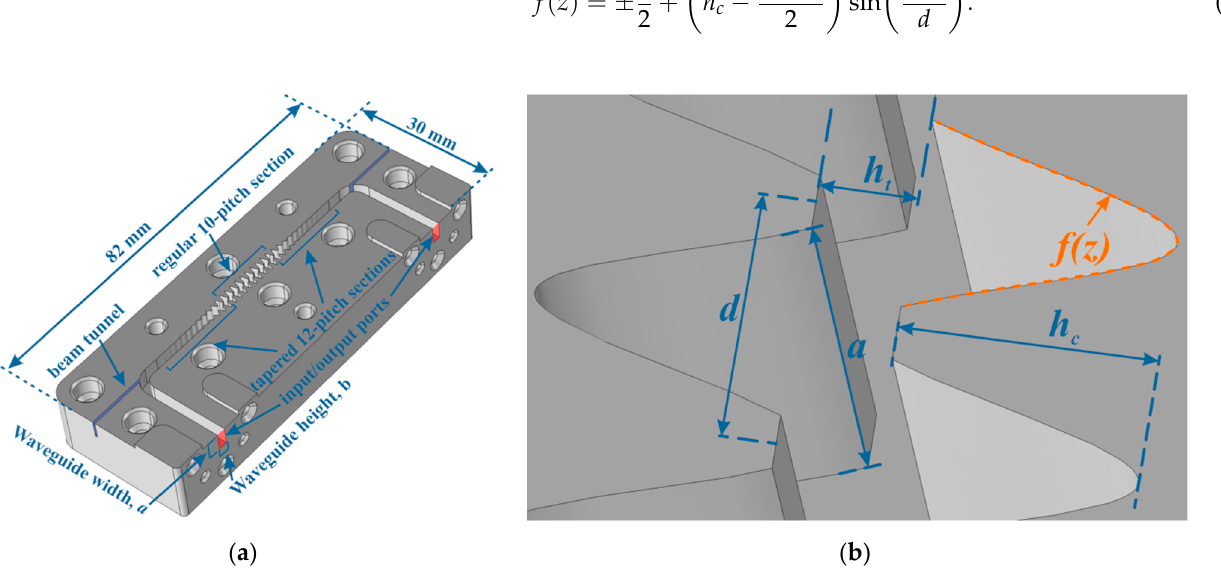
Figure 2. Schematic drawing of the proposed interaction structure: ( a ) view of the full ‐ scale circuit; ( b ) an enlarged view of a single period in the regular 10 ‐ pitch section.